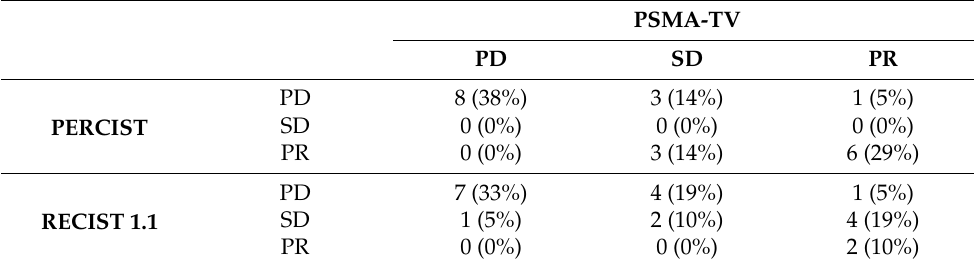
Table 2. Radiographic response assessment evaluating prostate-specific